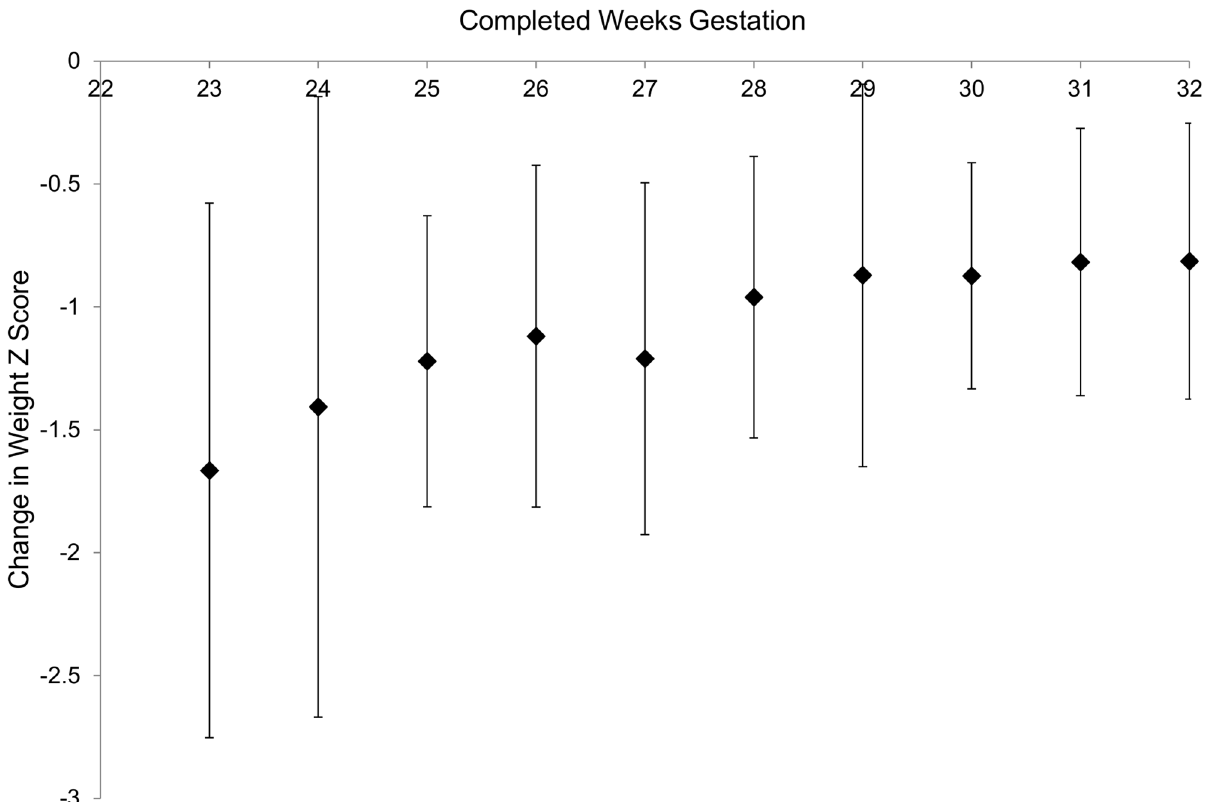
Fig 3. Change in weight Z score from birth to discharge (mean ± SD) vs. completed weeks gestation at birth for reference NICU (Mount Sinai). Regression line y = 0.066x-2.867, R 2 = 0.063 (p < 0.001).